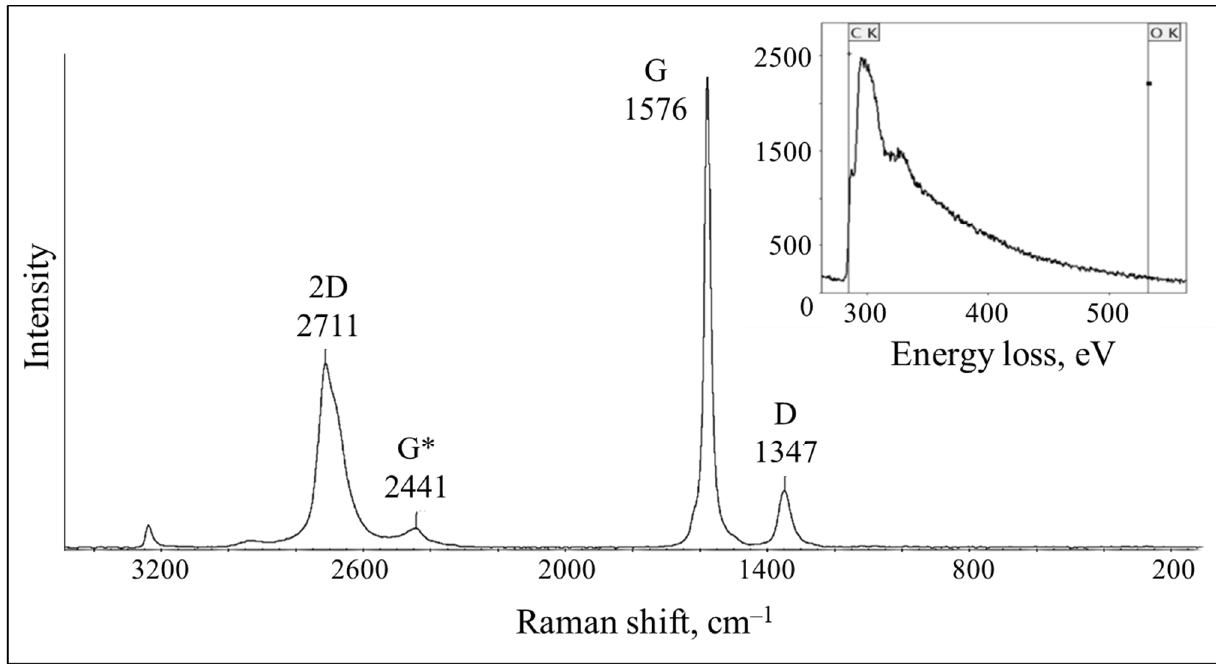
Figure 2. Raman and EELS (inset) spectra of the graphene obtained in isopropanol by ultrasonic treatment. G*‒overtone.